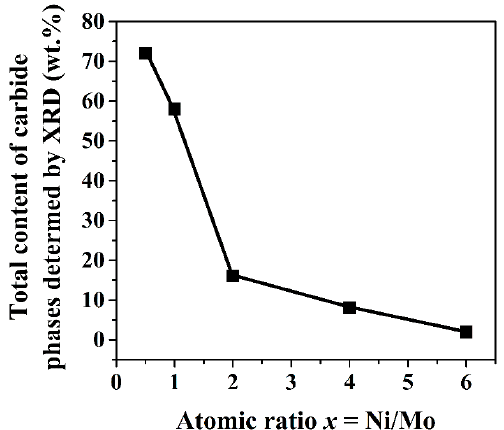
Figure 7. Dependence of the total content of carbide phases on the atomic ratio x = Ni/Mo for the calcined and reduced Ni x MoC–SiO 2 (400/600) catalysts.